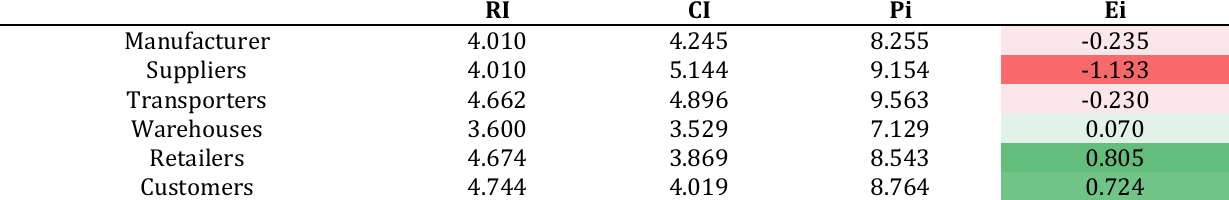
Table 6: Showing prominence and relation